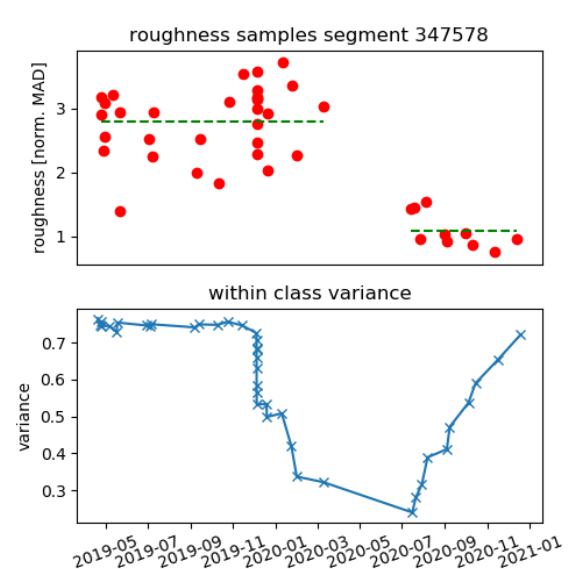
Figure 9. Plot of adjusted roughness observations over time for an exemplary street segment. The temporal discontinuity results from a new asphalt surface in May 2020, before it had several cracks.